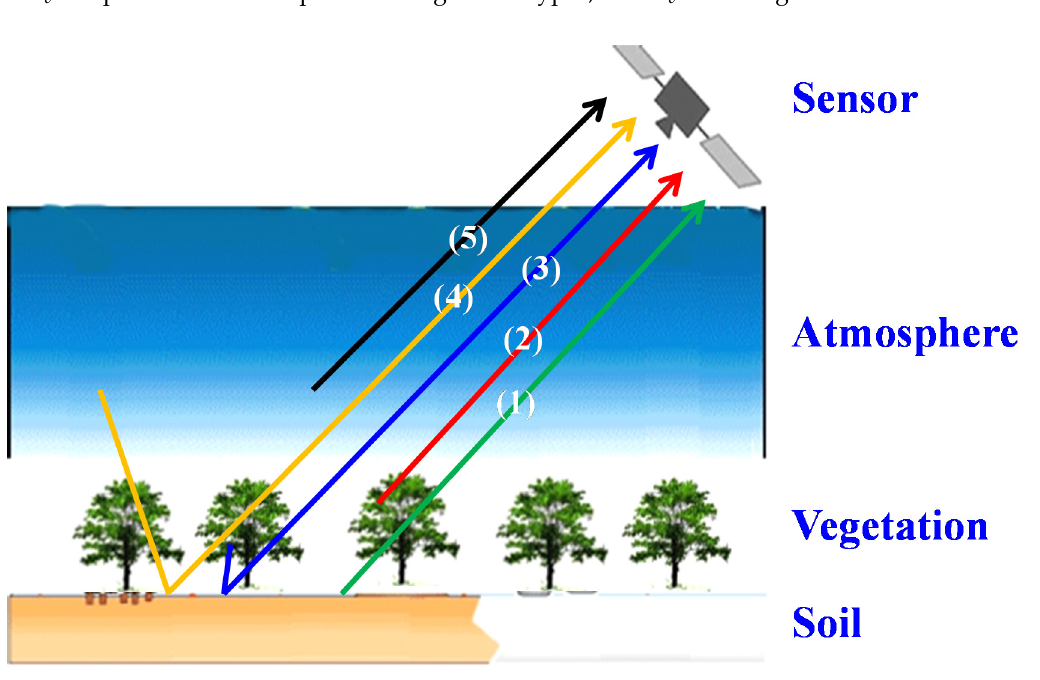
Figure 1. Radiation components received by a passive microwave (PMW) sensor at the top of the atmosphere (TOA): (1) soil-emitted radiation attenuated by the vegetation and the atmosphere; (2) vegetation upwelling radiation attenuated by the atmosphere; (3) vegetation downwelling radiation reflected by the surface and attenuated by the vegetation and the atmosphere; (4) atmospheric downwelling radiation and cosmic background radiation attenuated by the vegetation, reflected by the surface, and attenuated by the atmosphere; and (5) atmospheric upwelling radiation.